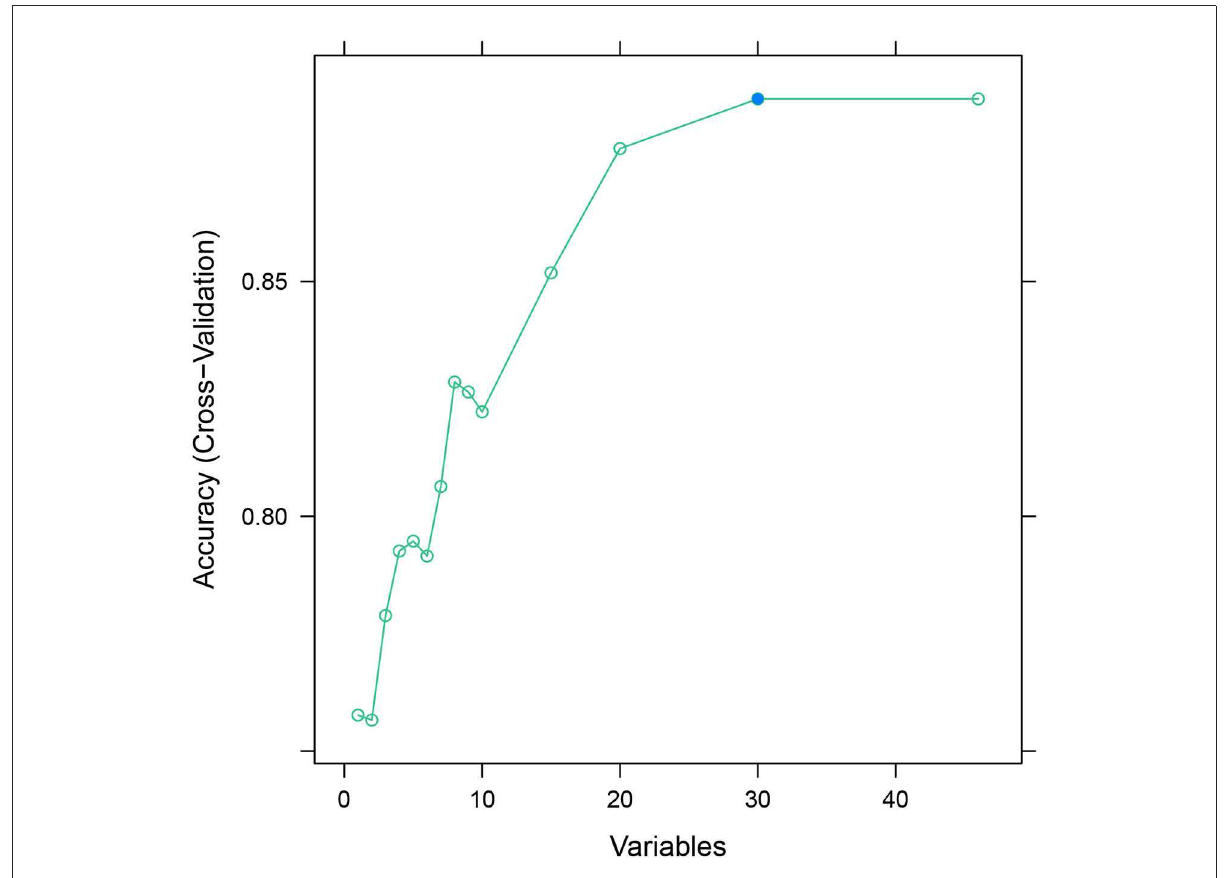
FIGURE2 Recursive feature elimination regression